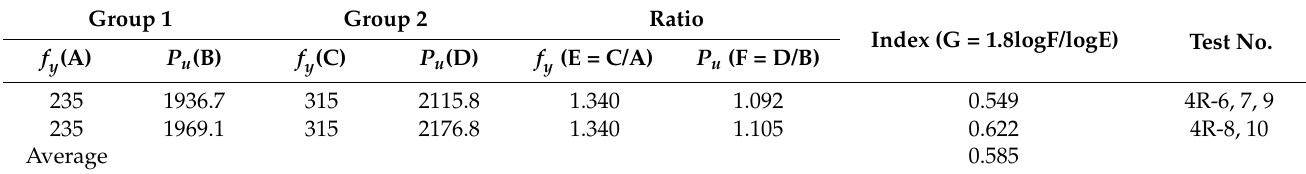
Table 11. Index value for the variable of f y